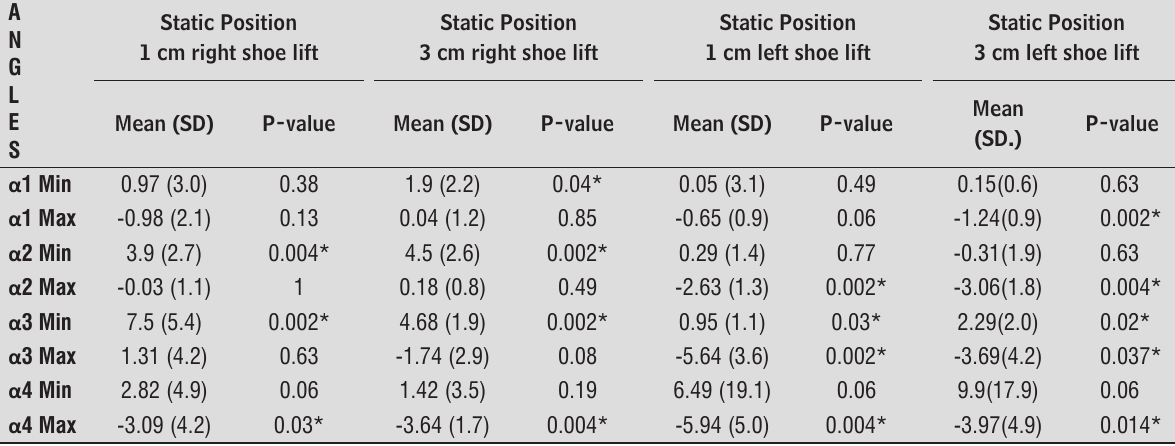
Table 4 - Difference between means (maximum and minimum) of a1, α 2, α 3 and α 4 in the static position with shoe lifts of 1 cm and 3 cm in relation to the static position without shoe lift and p